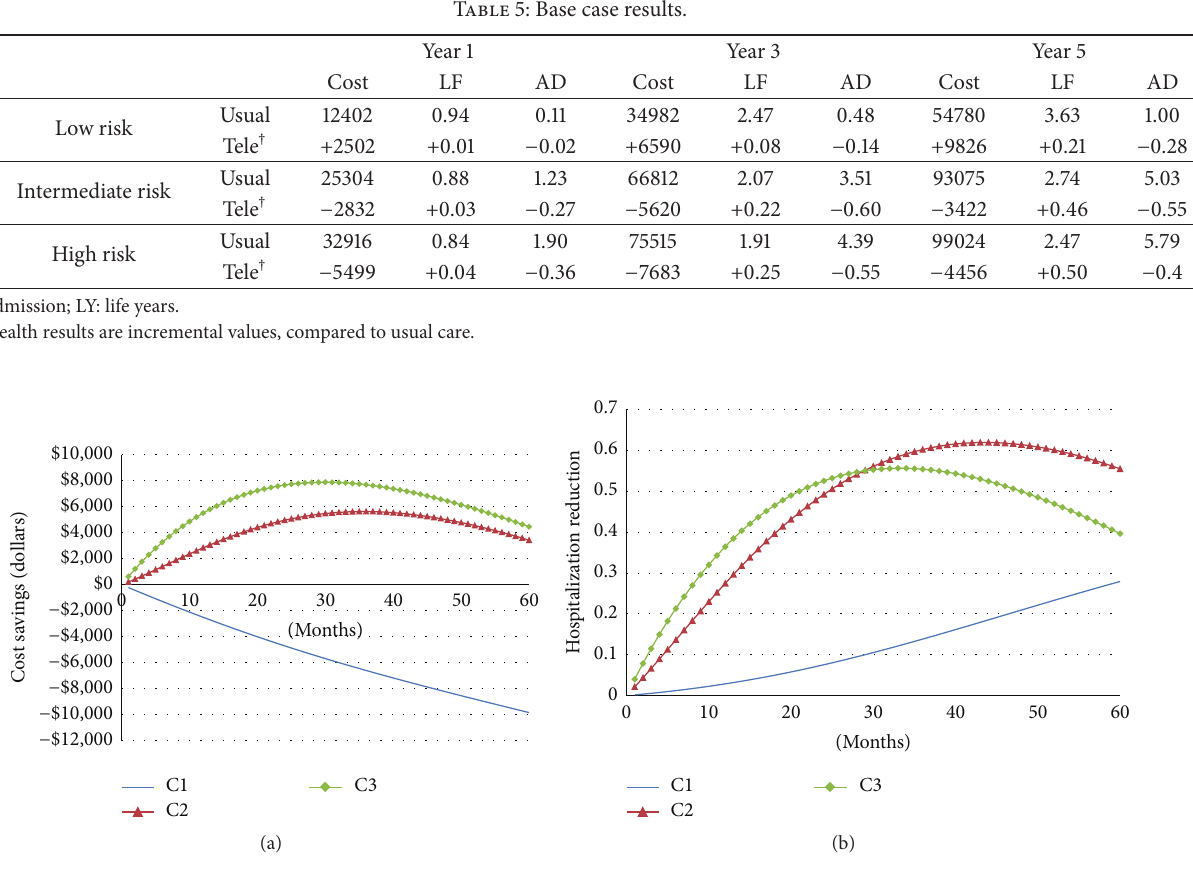
Figure 4: Base case analyses for three cohorts. (a) Cost saving curves as a function of number of years on telehealth programs; (b) hospitalization reduction curves as a function of number of years on telehealth programs.